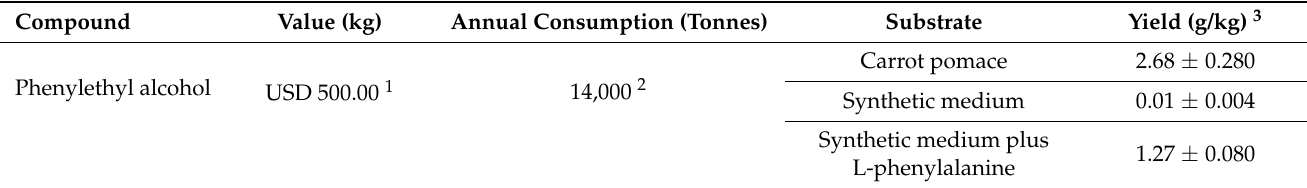
Table 3. Phenylethyl alcohol: value, estimated world consumption, and yield on carrot pomace and synthetic media fermented with Brettanomyces bruxellensis